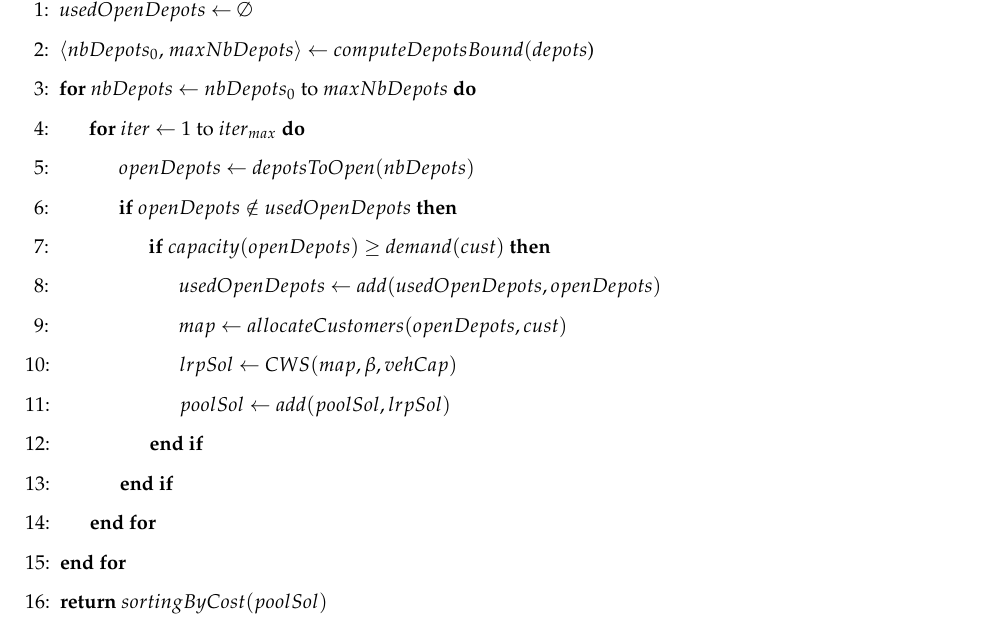
Algorithm 1 Constructive heuristic ( cust , depots , vehCap , β , iter max